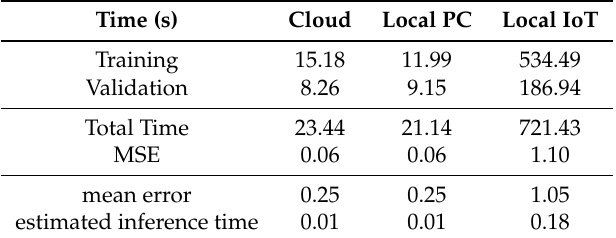
Table 5. LSTM model with Open Knowledge IoT Project (OKIoT) test bed data. One month, nine frequent events, window size of 20 events, 2359 events for training, and 1011 events for validation.